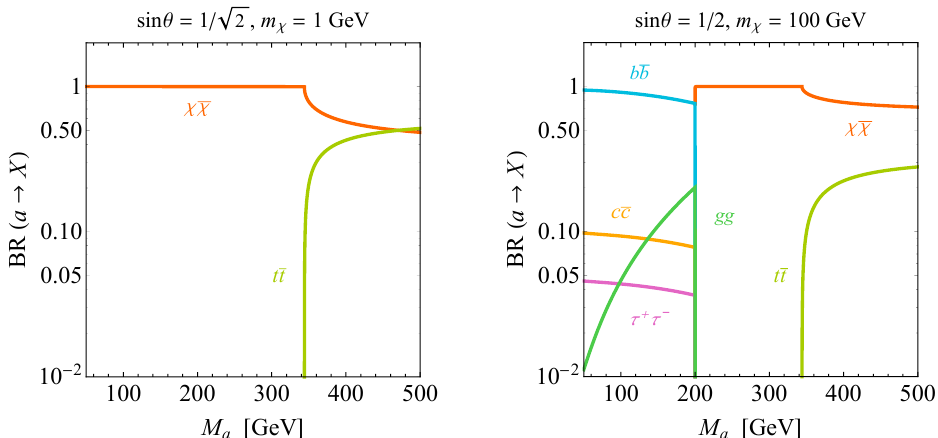
Figure 2 . Branching ratios of the lighter pseudoscalar a as a function of its mass for two di(cid:11)erent choices of sin (cid:18) and m (cid:31) as indicated in the headline of the plots. The other relevant parameters have been set to tan (cid:12) = 1, M H = M A = M H (cid:6) = 750 GeV and y (cid:31) = 1. Notice that for this speci(cid:12)c tan (cid:12) value the branching ratios of the pseudoscalar a do not depend on the choice of Yukawa